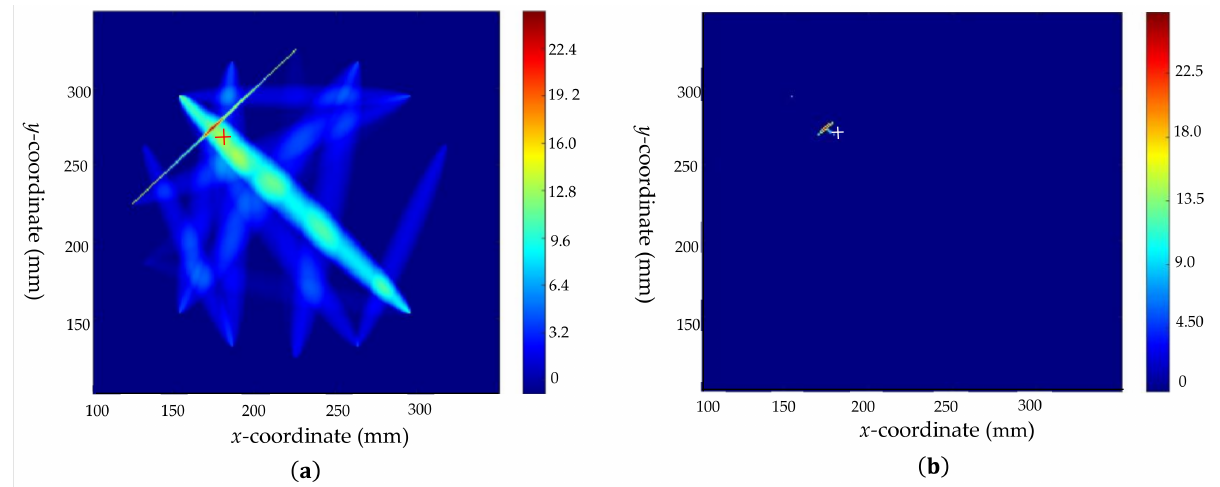
Figure 10. The imaging results of defect 1: ( a ) after optimization; ( b ) threshold processing result after